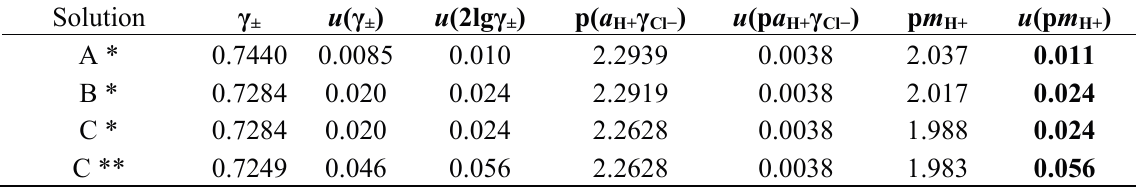
Table 1. Acidity function p( a H+ γ Cl − ) and p m H+ values with their respective uncertainty, u , budgets assessed in different background solutions: A, B and C.